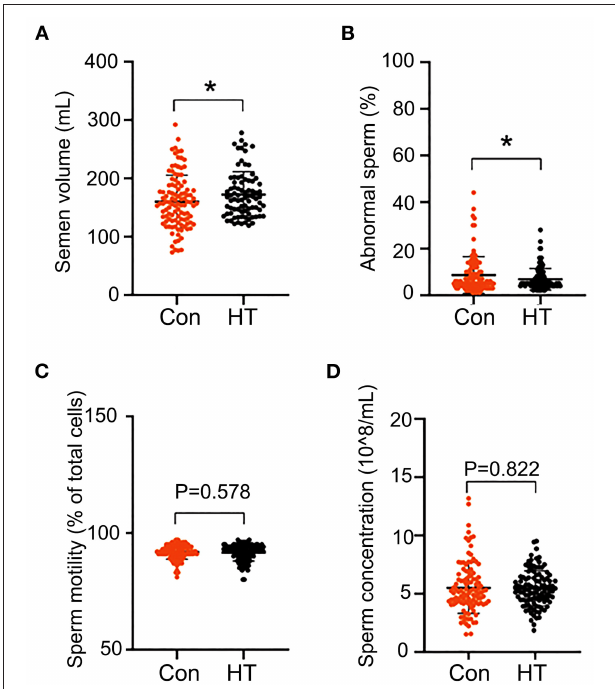
FIGURE 6 | Long-term effects of HT on semen quality. After HT supplementation, semen quality was determined every 5 days for 2 months (no HT supplementation). (A) Semen volume. (B) Abnormal sperm. (C) Sperm motility. (D) Sperm concentration. Data were expressed as the mean ± SEM. * P < 0.05.